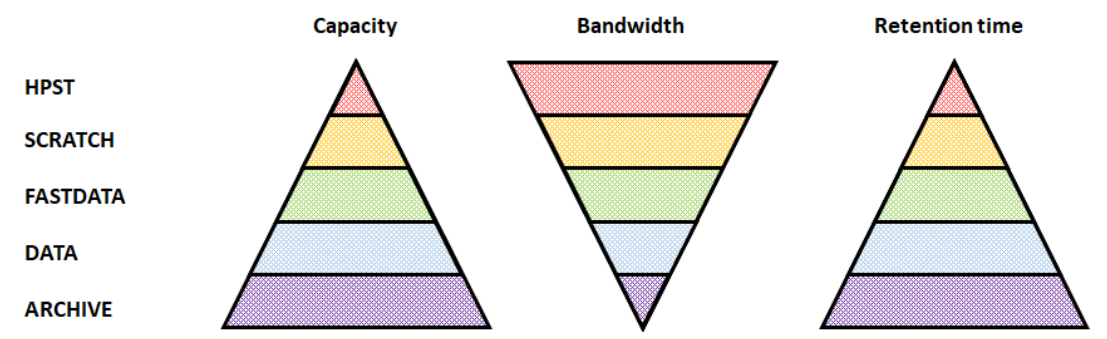
Figure 2: Schematic representation of the storage tiers in JUST with their capacity, bandwidth and (anticipated) data retention time characteristics. For simplicity, the small HOME file system as well as the PROJECT file system, that is solely accessible for compute projects, are not shown in the